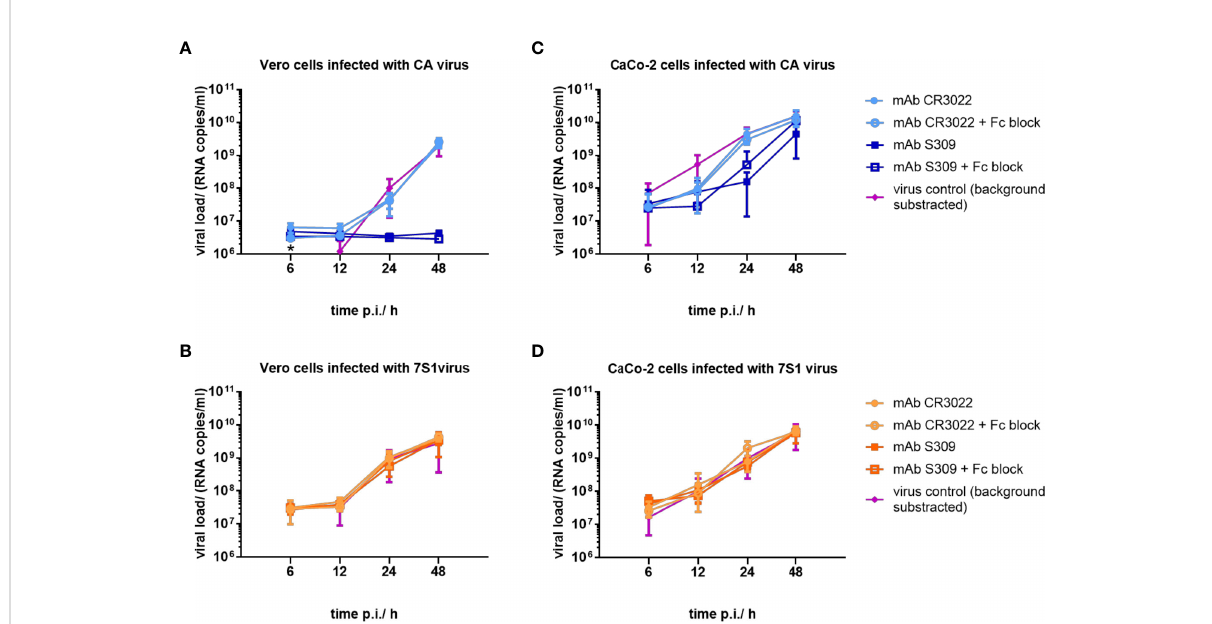
FIGURE 4 Replication kinetics of SARS-CoV-2 strains before and after selection with S309. (A, B) Vero and (C, D) CaCo-2 cells were infected with input (CA) and resistant (7S1) SARS-CoV-2 viruses using a multiplicity of infection of 0.05. Viruses were cultivated with CR3022 (squares) and S309 (circles) at a concentration of 5 µg/ml in the absence and presence of FcR-blocking reagent. Viral supernatants were harvested at 6h, 12h, 24h, and 48h post infection and analyzed using RT-qPCR. A control with paraformaldehyde- fi xed cells was included to quantify background viral load. Virus control (triangles) shows viral loads in the absence of antibodies with background subtracted. Mean and standard error of three independent experiments on Vero cells and four independent experiments on CaCo-2 cells are shown. The asterisk in Figure 4A indicates a mean viral load in the virus control below the background level at 6h